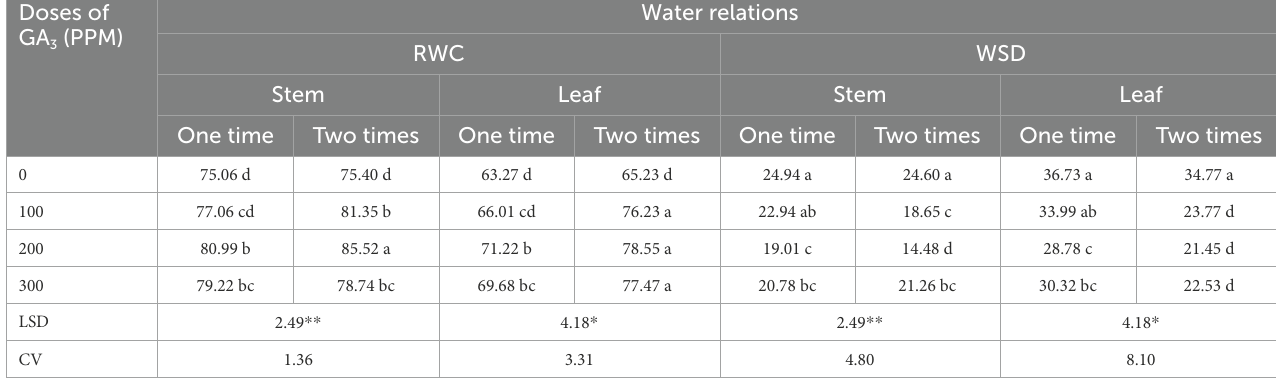
TABLE 3 The RWC and WSD in different plant parts of mungbean in response to exogenously applied different concentrations of GA 3 at varying frequencies. Doses of GA 3